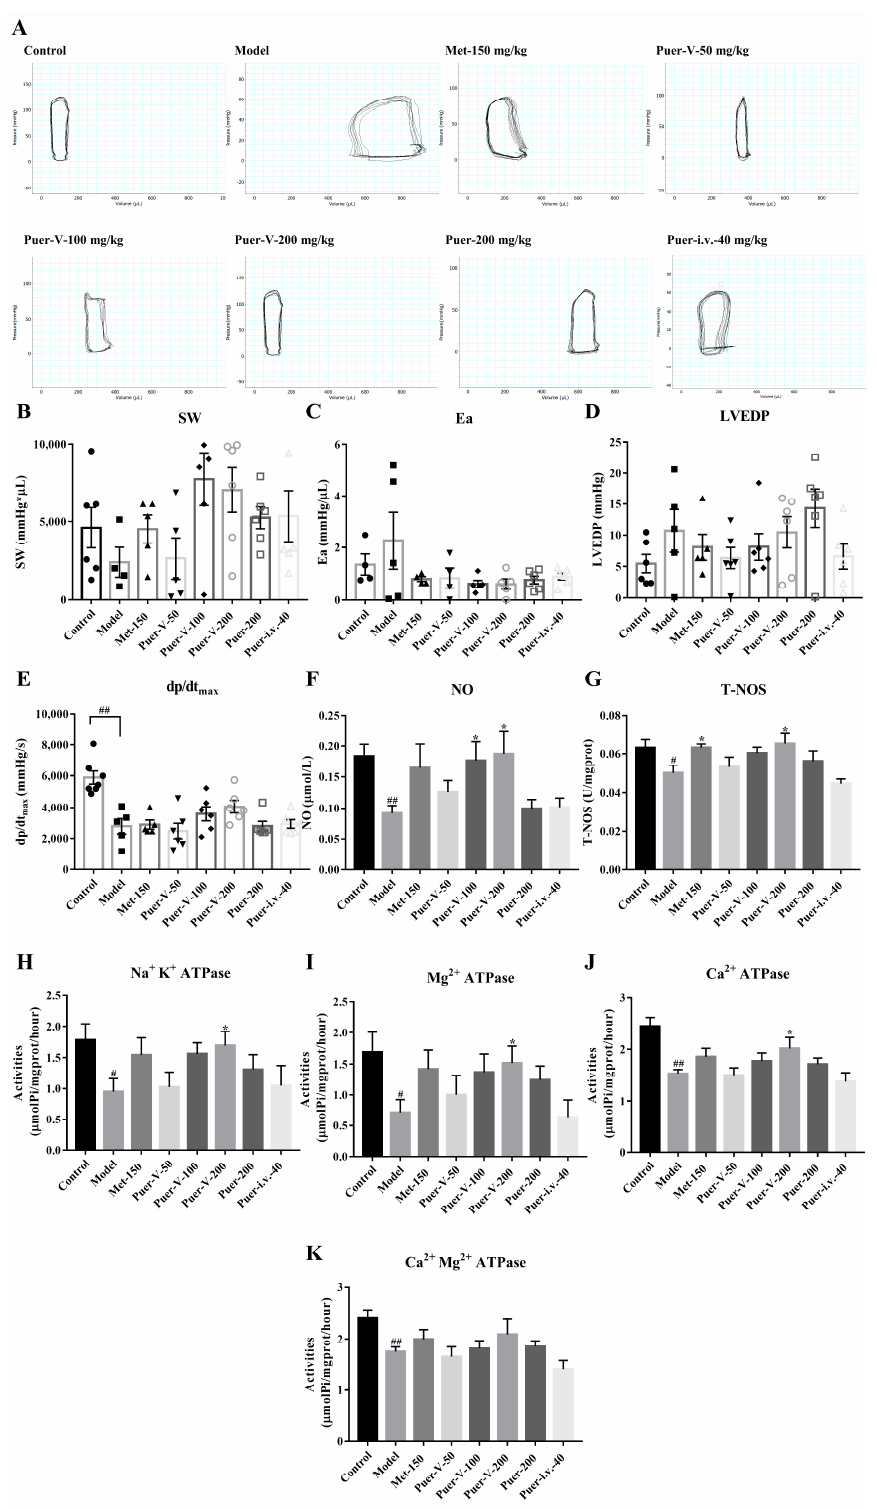
Figure 4. Puerarin-V enhanced the function of hemodynamics and left ventricular. ( A ) The situation of P–V loop of different groups, ( B ) LVSW, ( C ) Ea, ( D ) LVEDP, and ( E ) dp/dt max . ( F ) The content of NO. ( G ) The activity of NOS. ( H ) The activity of Na + -K + -ATPase. ( I ) The activity of Mg 2+ -ATPase. ( J ) The activity of Ca 2+ -ATPase. ( K ) The activity of Ca 2+ Mg 2+ -ATPase in diabetic cardiomyopathy rats. The data are represented by mean ± SEM (n = 6–8). # p < 0.05 and ## p < 0.01 vs. control group. * p < 0.05 vs. model